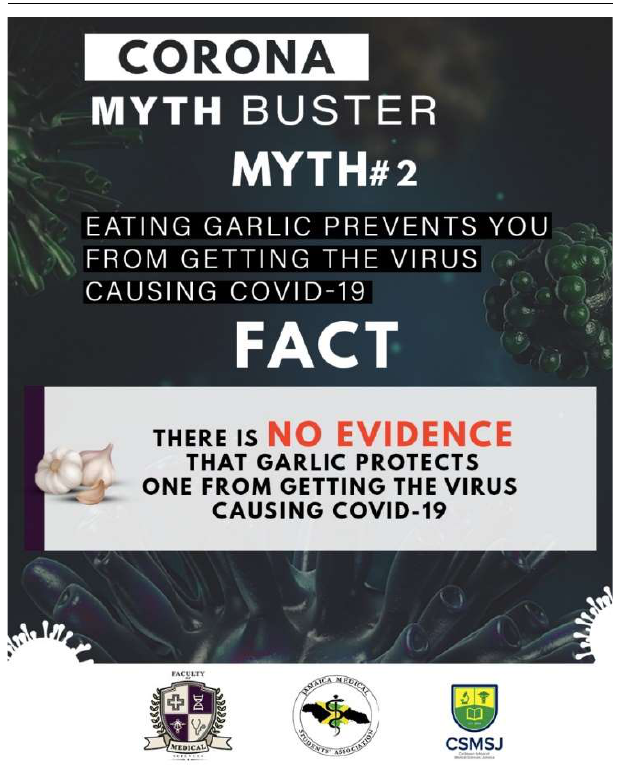
Figure 2. An example of a common myth that was debunked that was posted on our social media